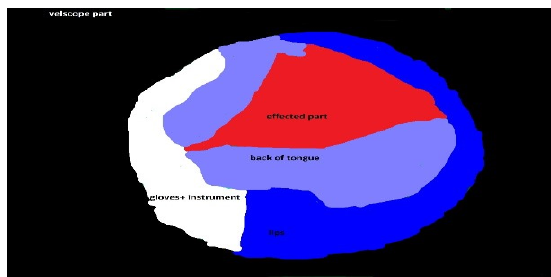
Figure 7. VELscope ® images of oral cavity annotated by the clinicians.